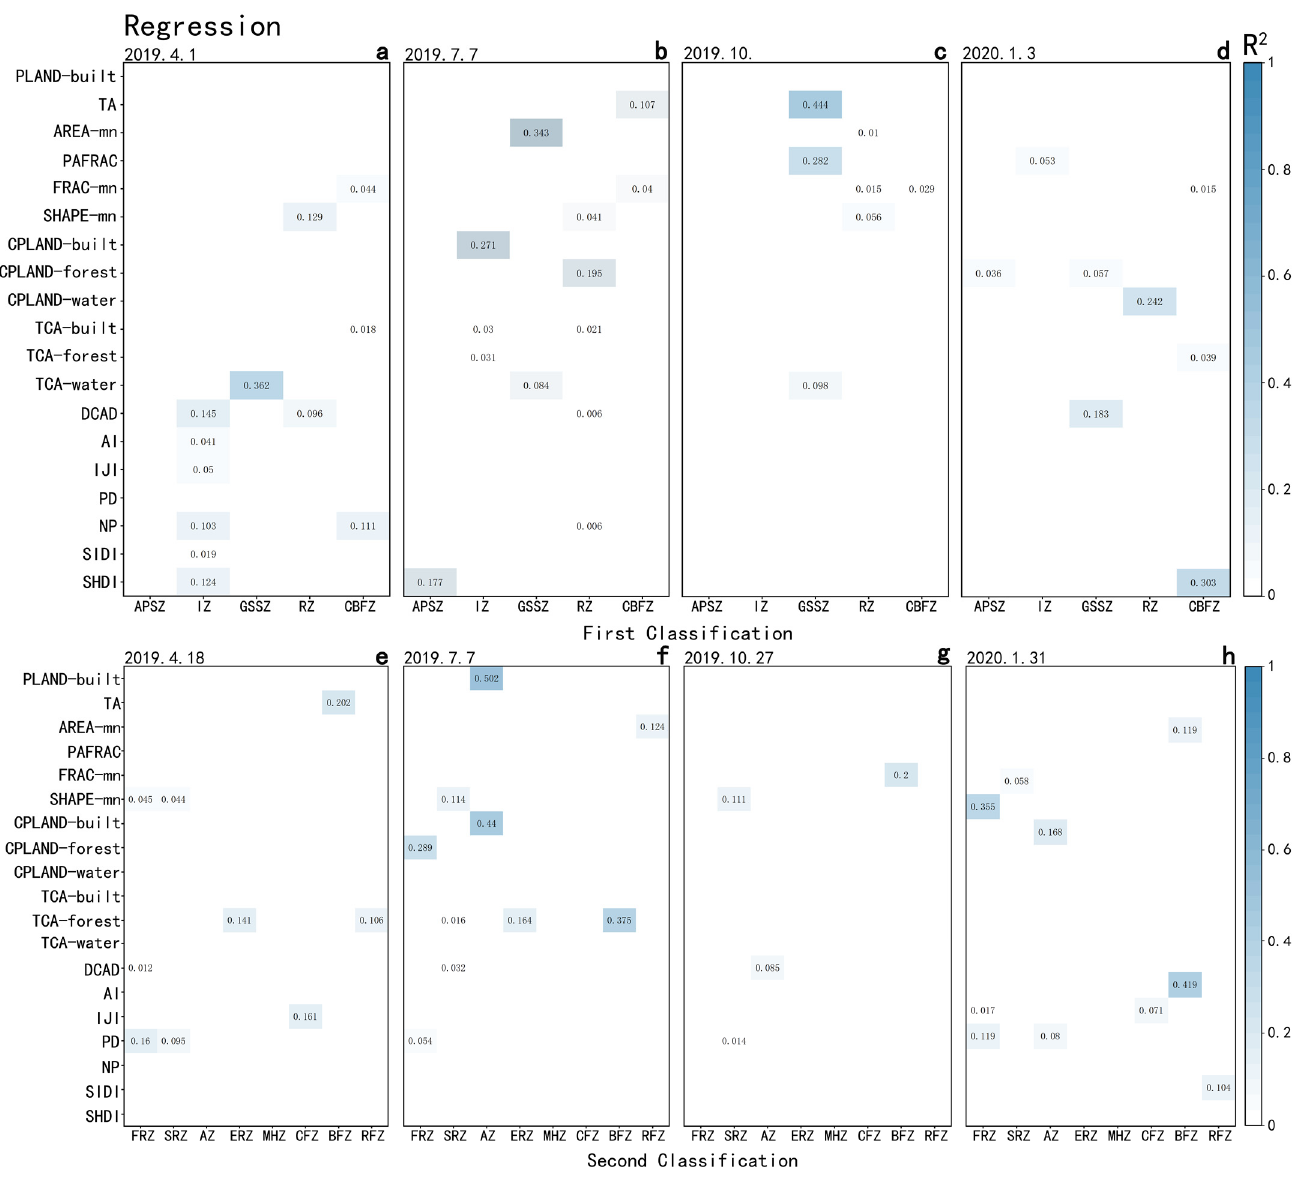
Figure 8. Stepwise multiple linear regression: ( a – d ) statistics for the first category of land use classification and LST; ( e – h ) statistics for the second category of land use classification and